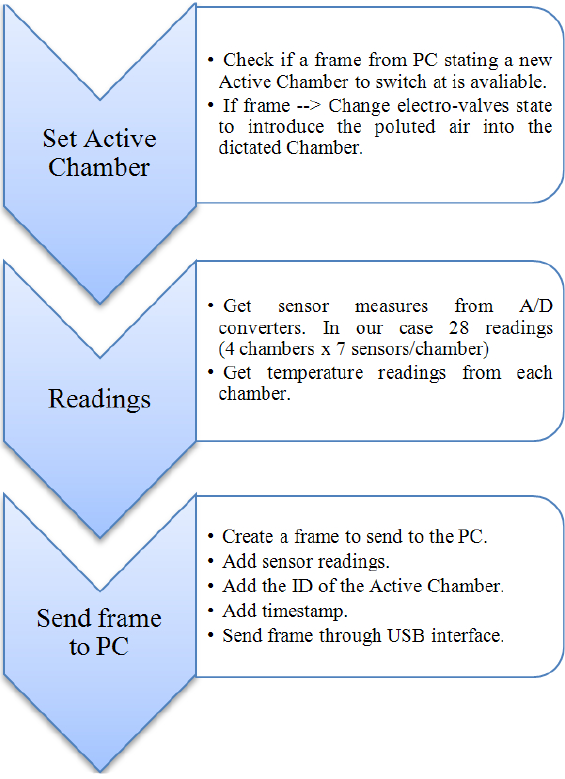
Figure 8. Operation flow of the embedded